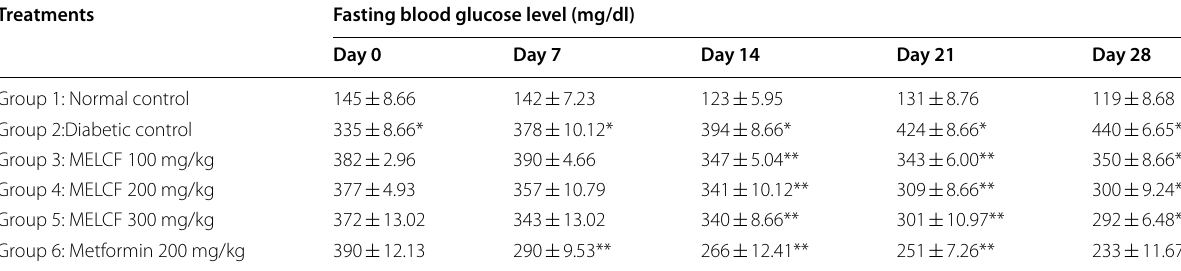
The values represented as mean SEM ( n 6). *Normal control group vs . diabetic control group (* p < 0.05), **All the treatment group vs . diabetic control group ± = (* p < 0.05) on same day Table 3 Effect of MELCF on body weight of diabetic mice